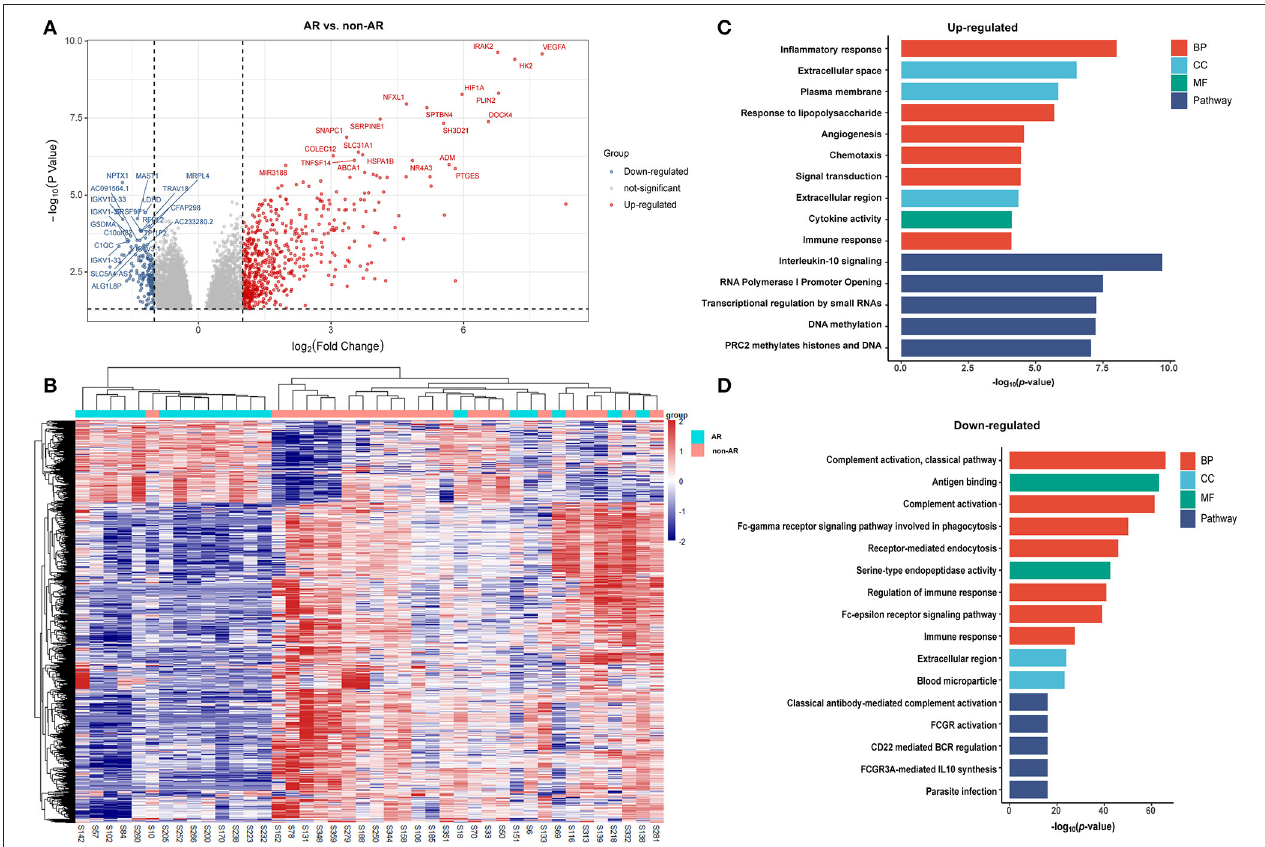
FIGURE 1 | DEGs and GO analysis (AR and non-AR recipients). (A) Volcano map of DEGs in AR vs. non-AR recipients. Red represents upregulated genes, and blue represents downregulated genes. A total of 975 DEGs were identified, among which 776 were upregulated and 199 were downregulated in patients with AR compared with patients with non-AR. (B) Hierarchical clustering heatmap analysis of DEGs. Red represents upregulated genes, and blue represents downregulated genes. (C) GO and pathway analysis of upregulated DEGs. GOs of inflammatory response and IL-10 signalling were the most significant items. (D) GO and pathway analysis of downregulated DEGs. GOs of the complement activation and classical antibody-mediated complement activation pathway were the most significant